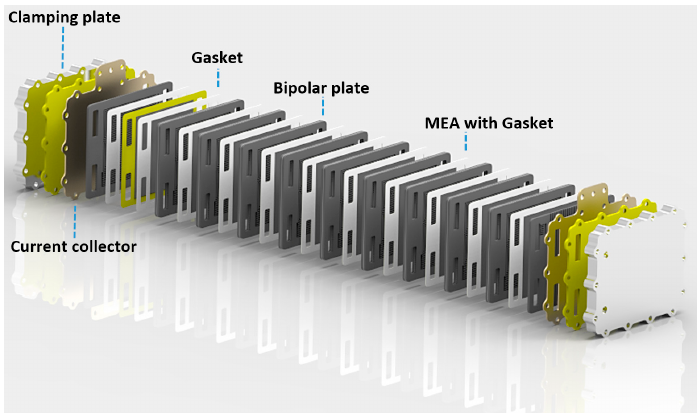
Figure 1. Exploded view of the modular DURAMET 10-cell direct methanol fuel cell (DMFC) stack. MEA: membrane-electrode assembly.